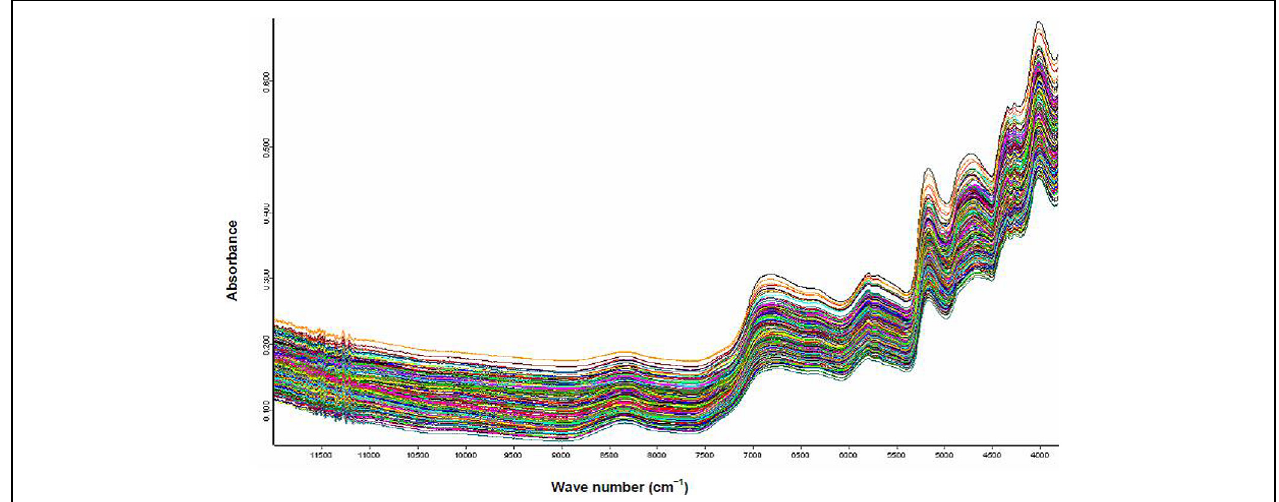
FIGURE 1 | Typical log (1/R) spectra for dry ground citrus leaves